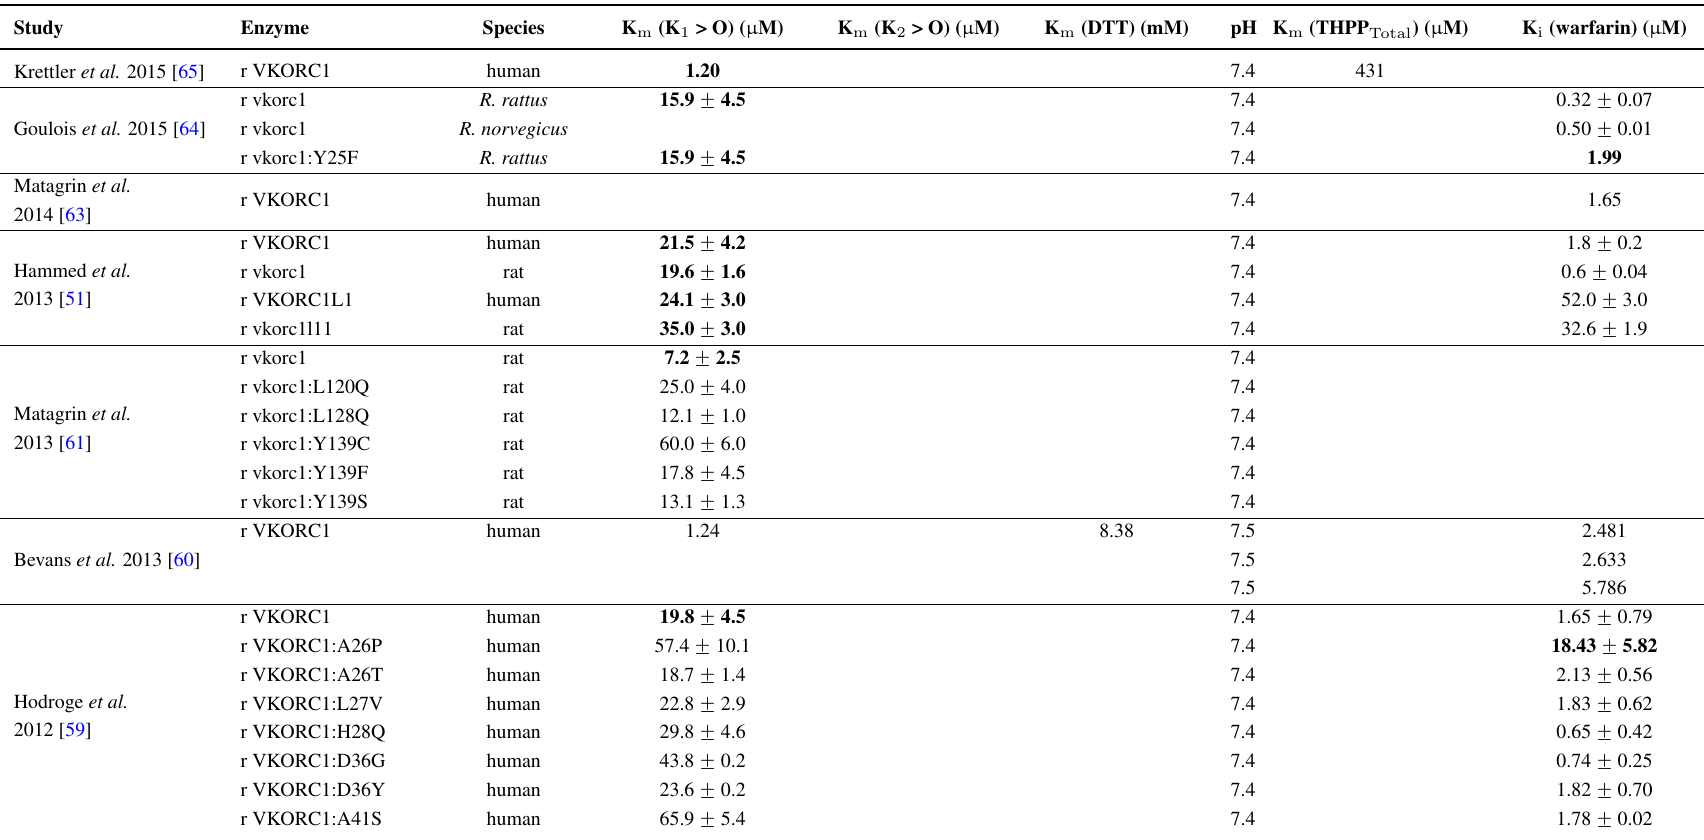
Table 1. Summary of results from published VKORC1 and VKORC1L1 enzymatics